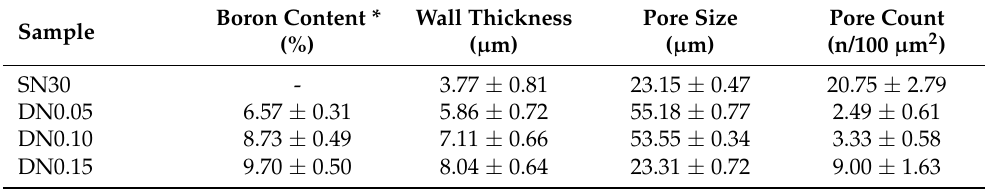
Table 3. Effect of borax concentration on wall thickness, pore size, and pore count of DN hydrogels.